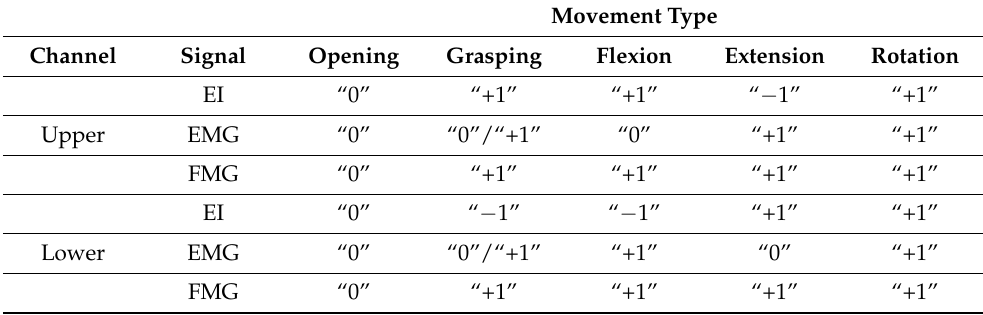
Table 2. Determining movement type («+1», increasing signal; «0», no change; « − 1», decreasing sig- nal).